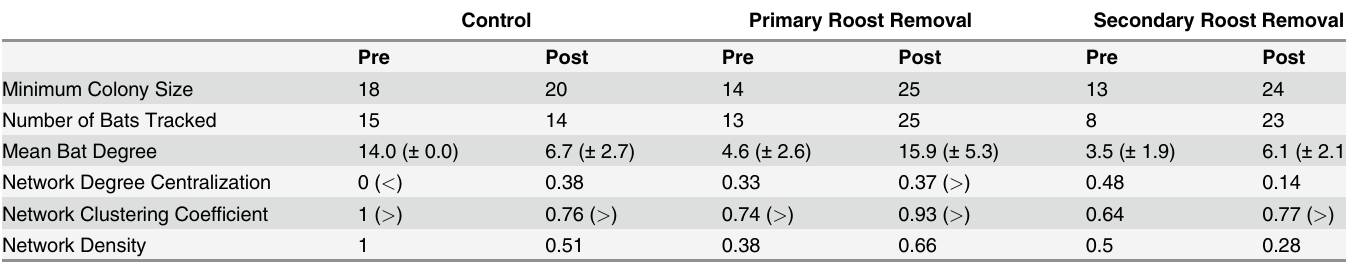
Table 5. Northern long-eared bat maternity colony social network metrics. Control Primary Roost